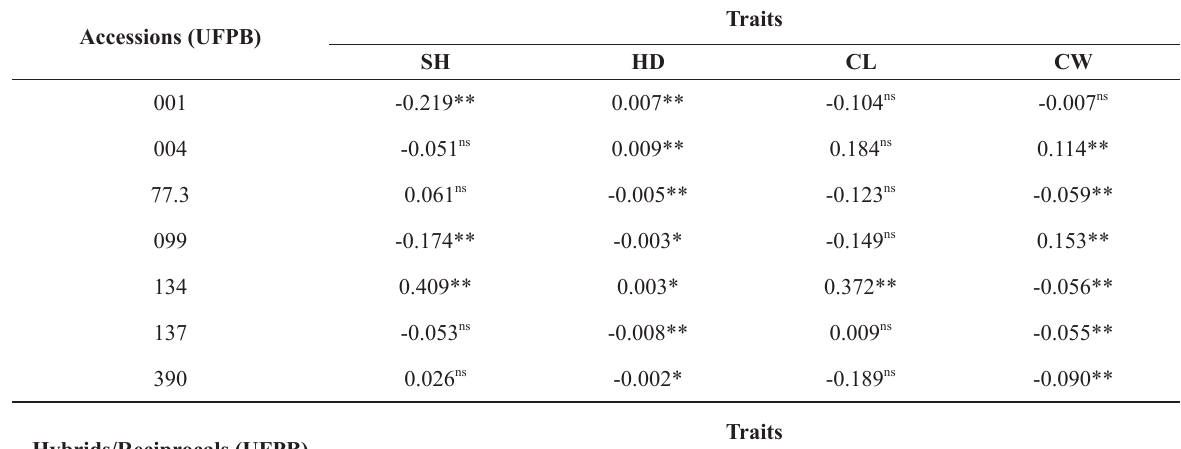
Estimated general combining ability ( ĝ i) and specific combining ability (s